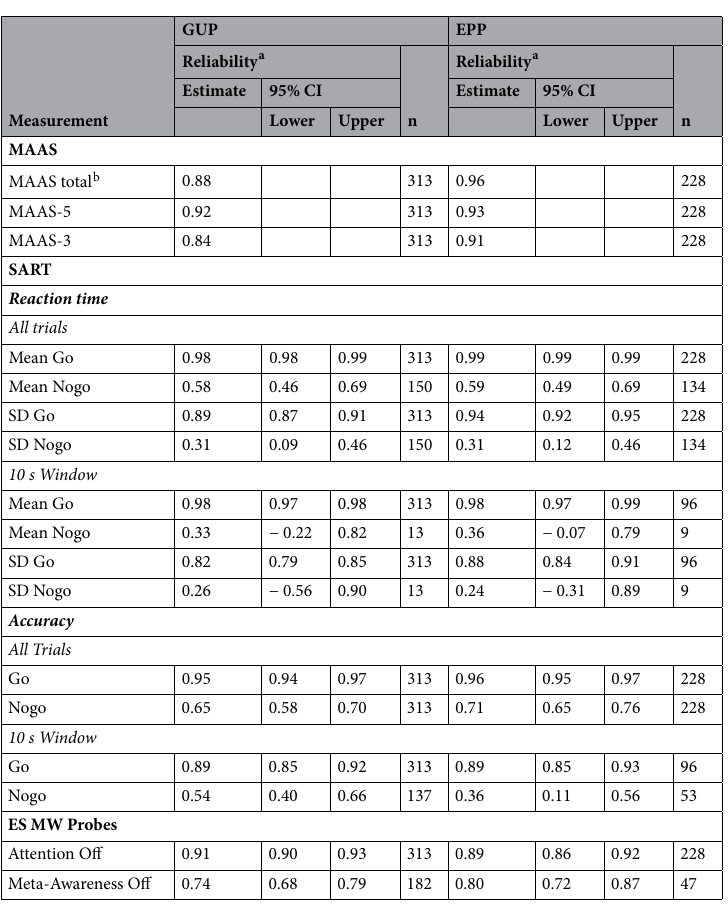
Table 4. Reliabilities for MAAS, SART, and ES measures in both samples. a Reliability estimates are Cronbach’s alphas in case of MAAS scores and split-half reliabilites for SART and ES measures. Split-half estimates are Spearman-Brown corrected and were derived using a permutation-based approach with 5000 random splits 57 . b MAAS total score included all 15 items in EPP, but only 14 items (excluding item 6) in the GUP. 95% CI = 95% confidence interval, SD = standard